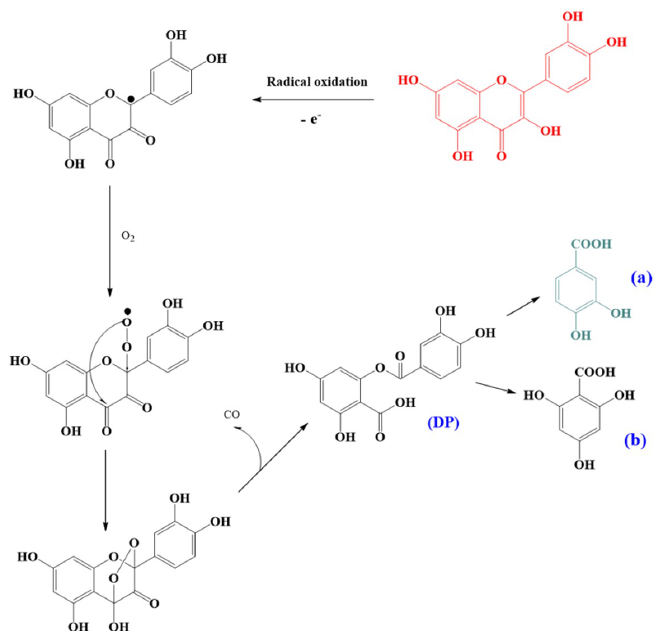
Figure 6. Putative pathway of radical‐mediated quercetin oxidation. (DP) depside; ( a ) protocatechuic acid (3,4‐dihydroxybenzoic acid); ( b ) phloroglucinol carboxylic acid (2,4,6‐trihydroxybenzoic acid).